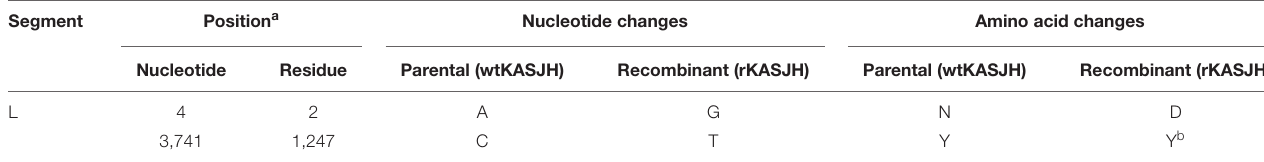
TABLE 1 | Sequence differences between the parental and recombinant